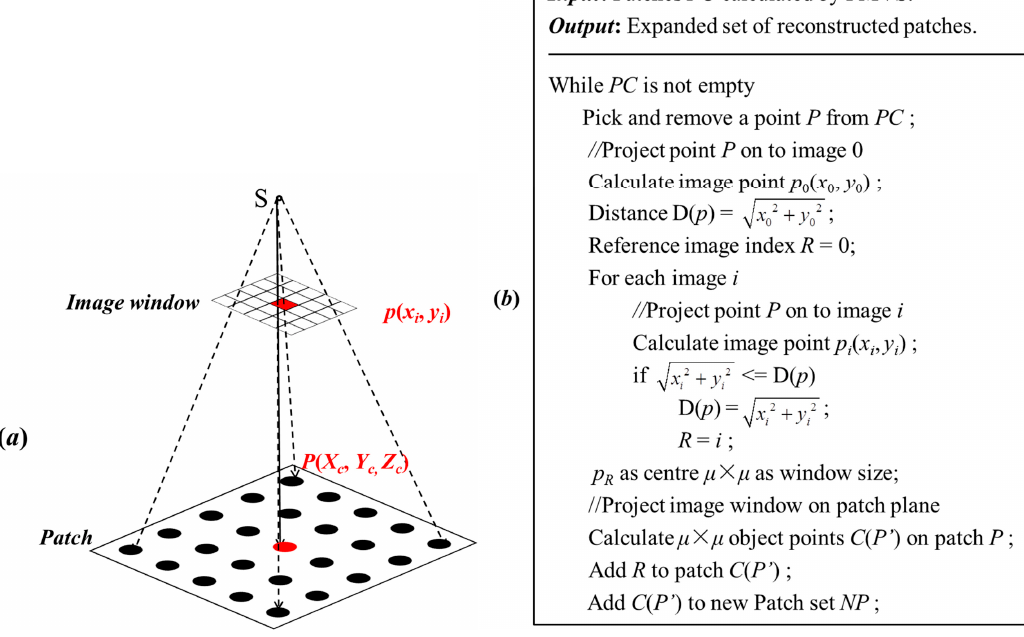
Figure 2. ( a ) Projection relationship between pixels (grids) in image window and object points (dots) in patch; ( b ) Process of patch-based point cloud expansion